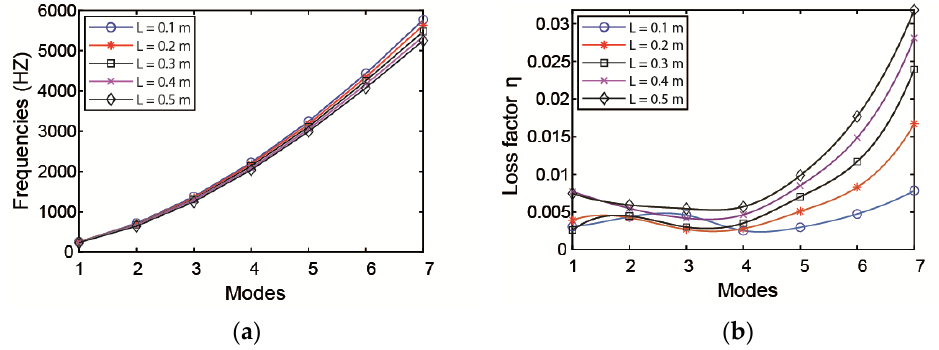
Figure 11. The influence of axial length of ACLD on the ( a ) natural frequency and ( b ) loss factor.